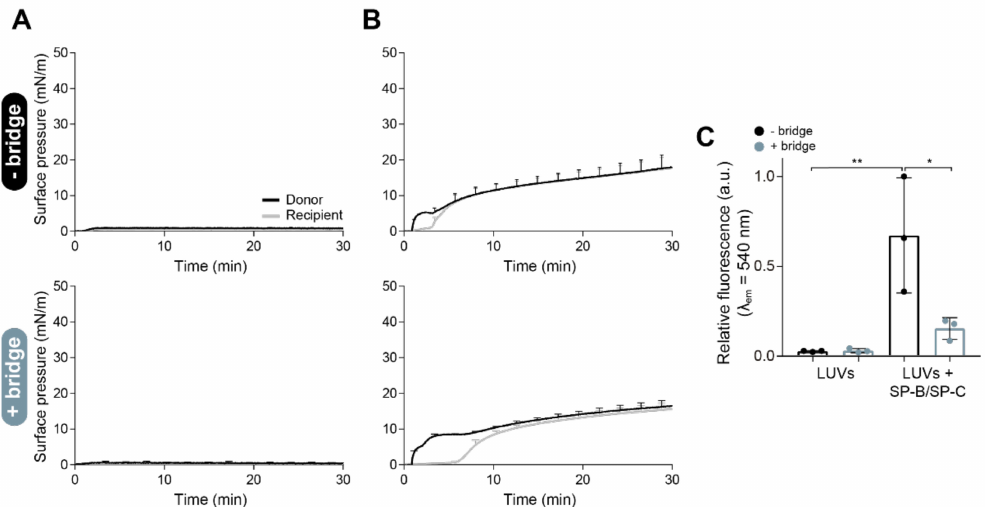
Figure 4. Interfacial spreading of lipidic or proteo-lipidic liposomes over the double-balance setup. Π -time isotherms of large unilamellar vesicles (LUVs) made of ( A ) DPPC:POPG (7:3, w / w ) and ( B ) DPPC:POPG (7:3, w / w ) + 2% ( w / w ) SP-B/SP-C (15 µ L, 20 mg/mL) labelled with 1% (mol/mol) NBD-PC, both without (upper graphs) and with (bottom graphs) the paper bridge connecting the recipient trough with the rest of the system. ( C ) Relative fluorescence emission of the NBD-PC collected by aspiration from the recipient interface at the end of each experiment. Mean and standard deviation from three independent replicas are represented. One-way ANOVA ( p = 0.004) followed by Tukey’s post-hoc test: (*) p < 0.05 and > 0.01, and (**) p ≤ 0.01 and >